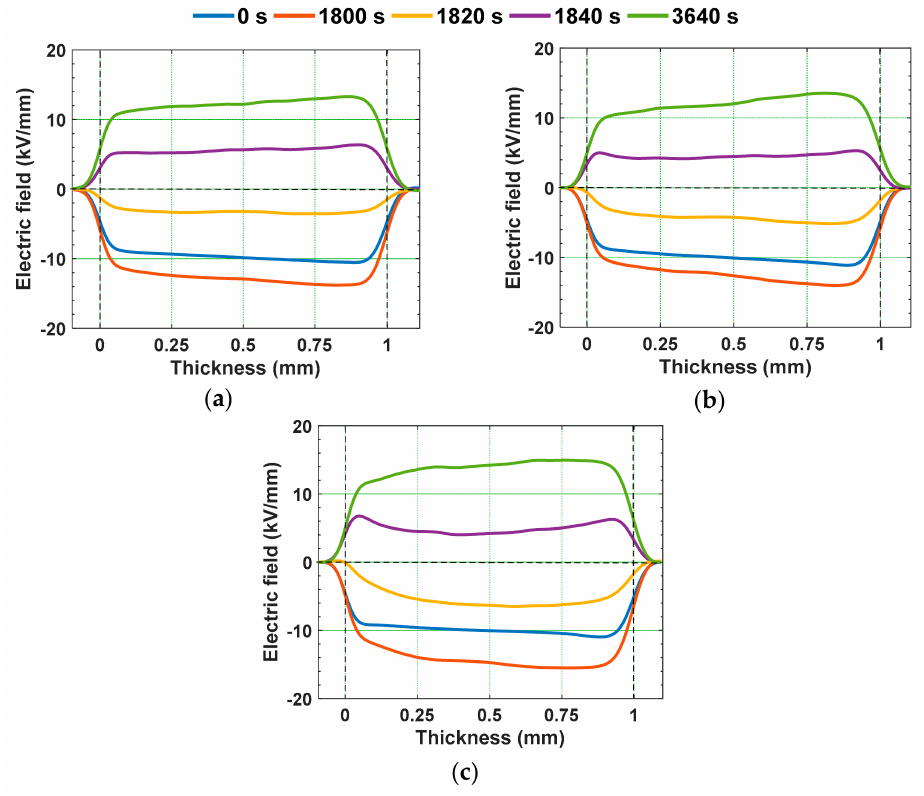
Figure 19. Electric field characteristics under voltage polarity reversal in ( a ) unaged specimen, ( b ) water aged specimen at RT, and ( c ) water aged specimen at 90 ◦ C